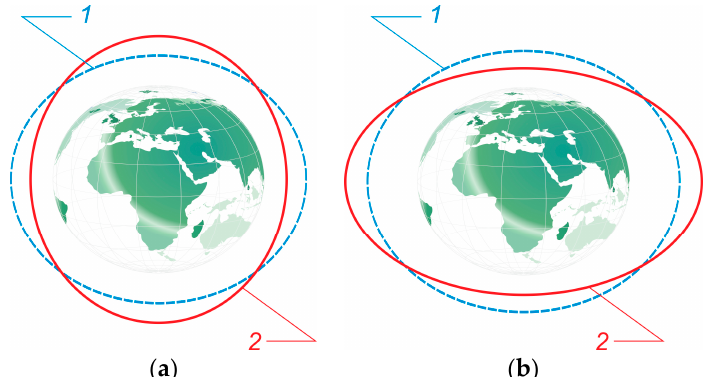
Figure 2. Isobaric surfaces in the atmosphere geostrophic model: 1—undisturbed; 2—disturbed. ( a ) the prolate geoid; and ( b ) the oblate geoid.